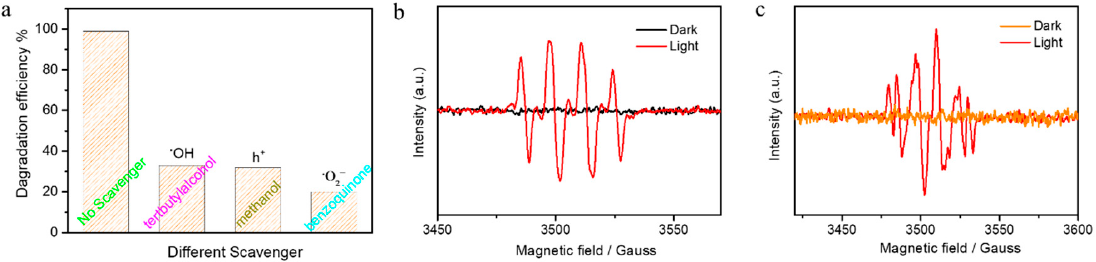
Figure 5. ( a ) Photodegradation efficiency of Vo–Sm–CeO 2 nanorods with different scavengers after 90 min. The ESR results of the Vo–Sm–CeO 2 nanorods: ( b ) DMPO-OH and ( c ) DMPO-O 2 − .